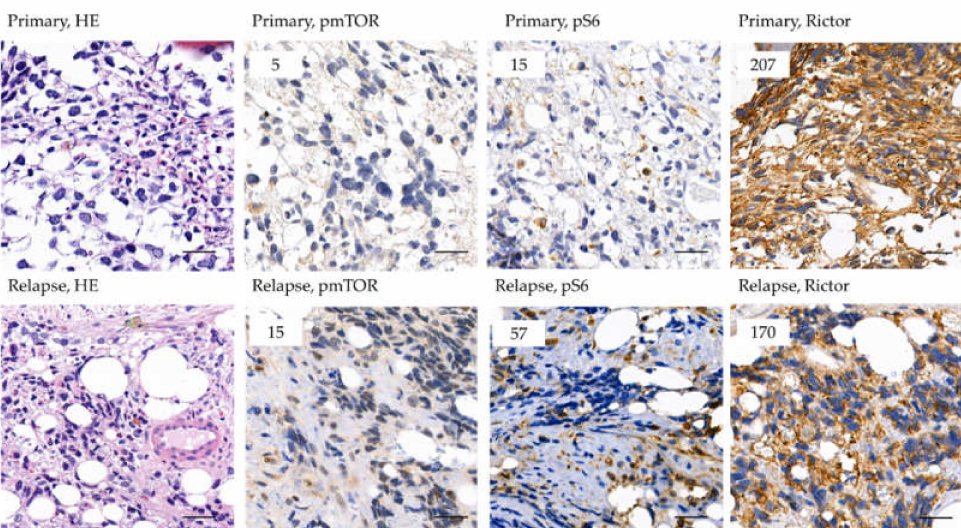
Figure 7. Expression of mTOR related markers of the patient treated with mTORC1 inhibitor. Representative areas of the immunohistochemical stainings (pmTOR, pS6, Rictor) are presented in the figure. The specimens belong to the patient (case 28), whose mTOR inhibitor therapy showed to be ine ffi cient. The patient had multiplex bone metastasis and all his tissue samples were bone marrow biopsies. DAB (brown) and hematoxylin were used as chromogen and counterstaining, respectively. The numbers in the left upper corner of the pictures refer to the given H-scores. Pictures were taken with CaseViewer 2.3 software (3DHistech Ltd., Budapest, Hungary). The scale bars show 25 µ